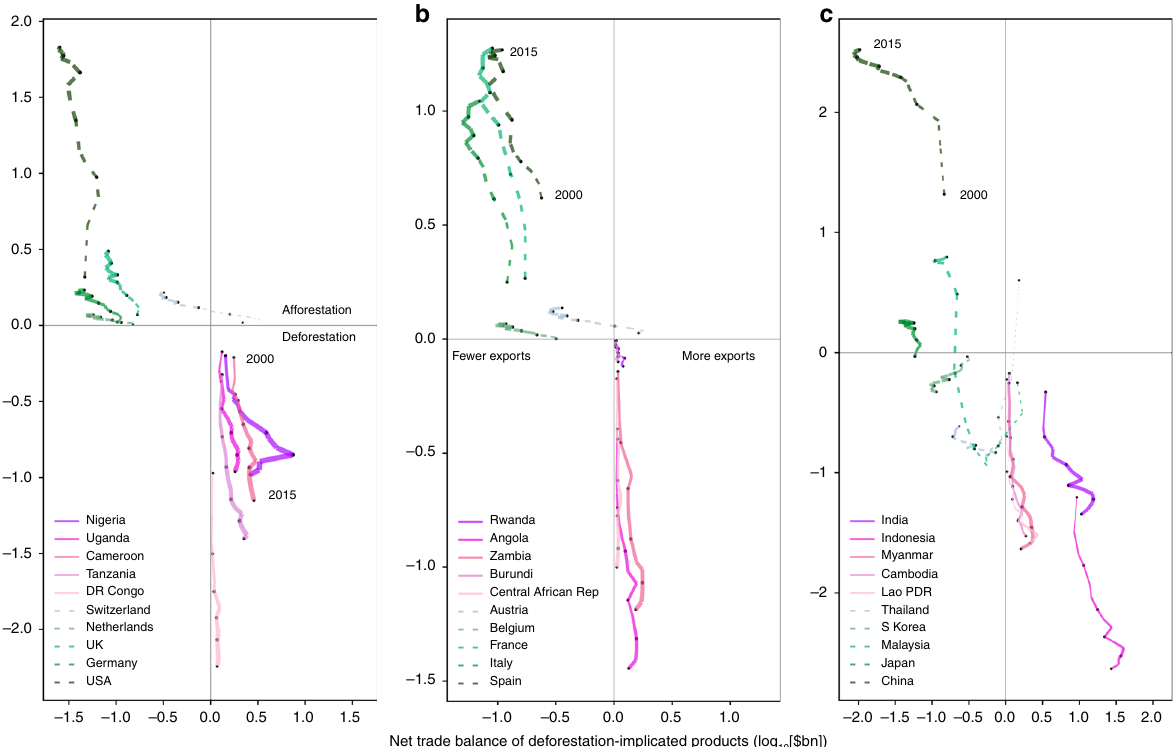
Fig. 4 Trends in forestation, trade in deforestation-implicated products, and post-2000 malaria footprints. Panels ( a ), ( b ) and ( c ) each show a collection of net exporting (magenta) and net importing (green) countries. Axes are logarithmic, with negative values representing deforestation (for example − 1 equals a cumulative 10,000km² forest loss since 1995) and product import (for example − 2 equals a US$100 bn import). Plotted points represent the years between 2000 and 2015 in 3-year intervals where line thickness is proportional to net malaria risk trade, and net exporters represented by a solid line, net importers by a dashed line. The time series proceeds from the origin outwards and also with increasing line thickness. As time progresses, richer countries import more deforestation-implicated products which causes deforestation in poorer countries, while at the same time preserving more of their own